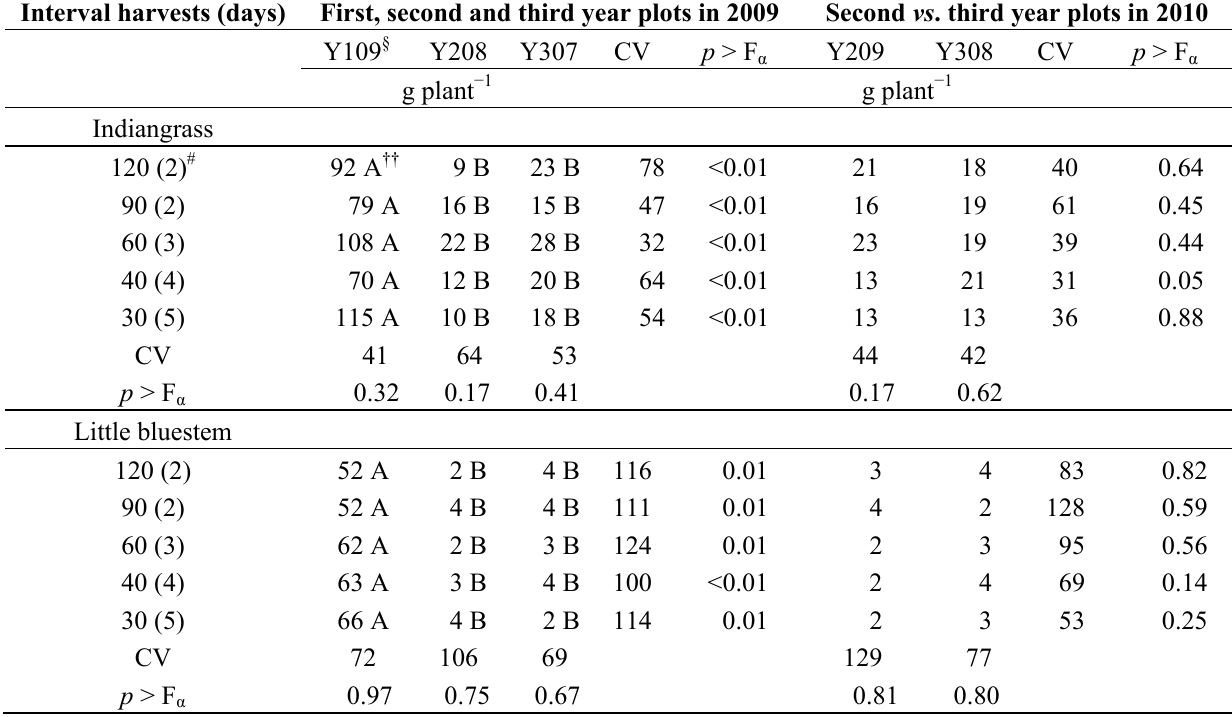
Table 3. Effects of harvest interval and duration † on recovery from last harvest event of indiangrass ( Sorghastrum nutans ) and little bluestem ( Schizachyrium scoparium ) plants in mixed native grass stands ‡ based on yield per plant in mid-May of two consecutive